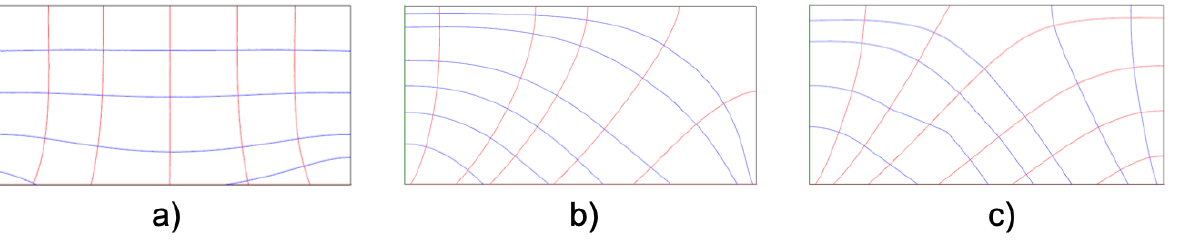
Figure 3. First (in blue color) and second (in red color) directions of PSLs for the three load cases: ( a ) CL, ( b ) SL, and ( c ) CSL.